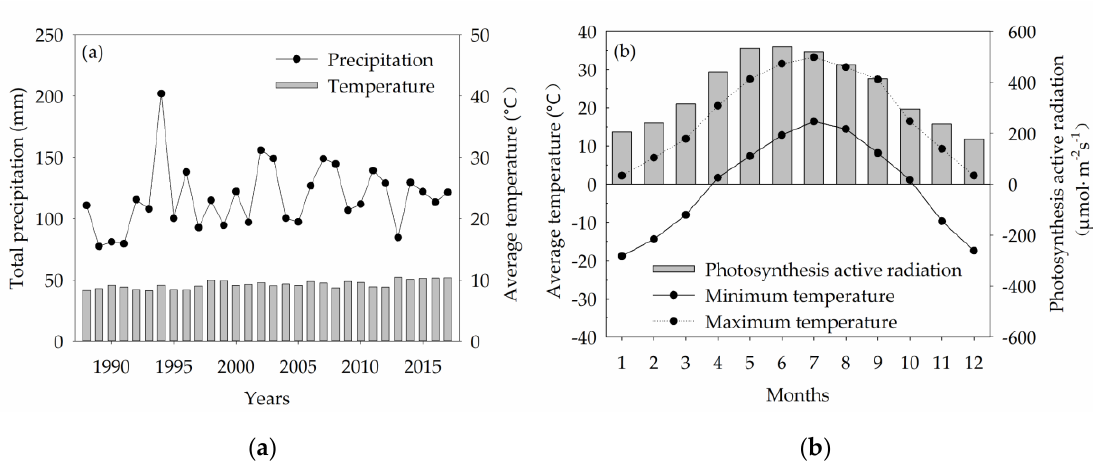
Figure 2. The characteristics of precipitation, temperature and photosynthesis active radiation (from meteorological data in the Drylands Salinization Station). ( a ) total precipitation amount and average temperature per year, ( b ) average temperature and photosynthesis active radiation per